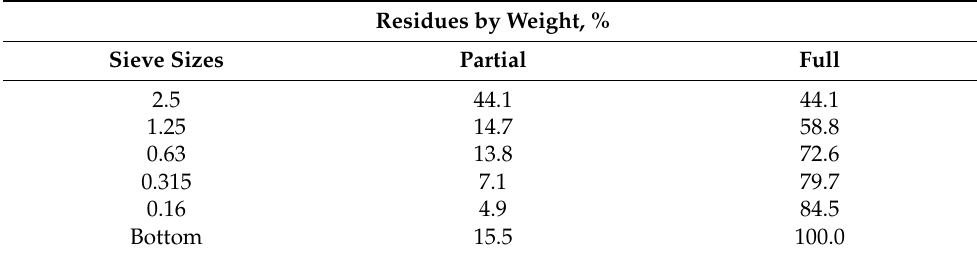
Table 5. Granulometric composition of concrete